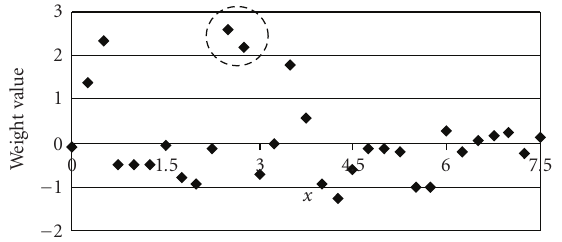
Figure 15: Correlation between the number of steps until catching the object in the invisibility area and the output of the 12th hidden neuron. The output varies according to the direction of motion and velocity of the object, although the number of steps until the catch is the same.